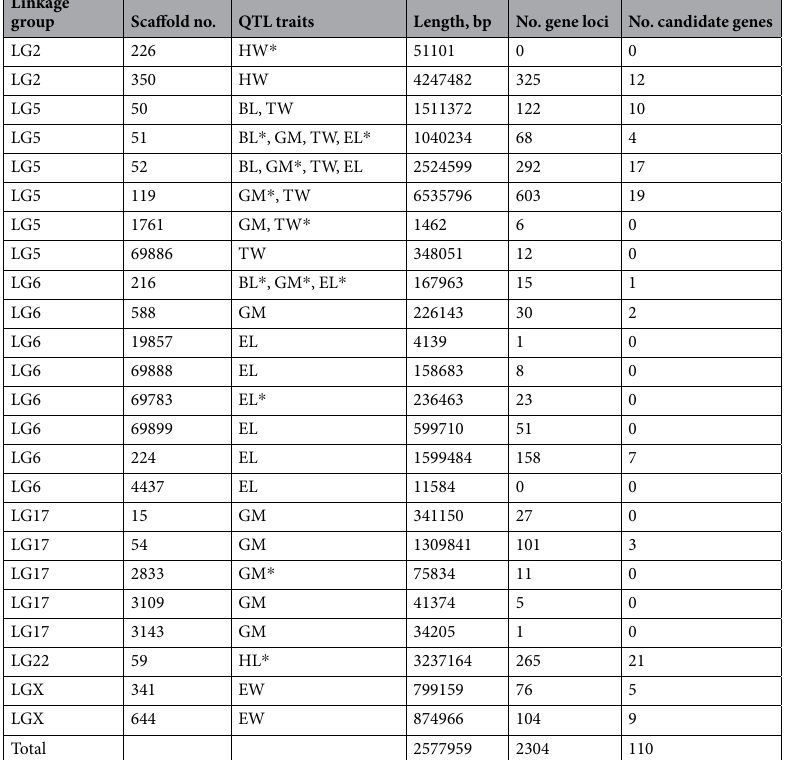
Table 3. Scaffolds of C . japonicus with body size QTLs. Asterisks indicate that the LOD peaks of the traits exist on the corresponding scaffolds. For candidate gene numbers, the numbers accounting for multi-locus genes on the same scaffold are